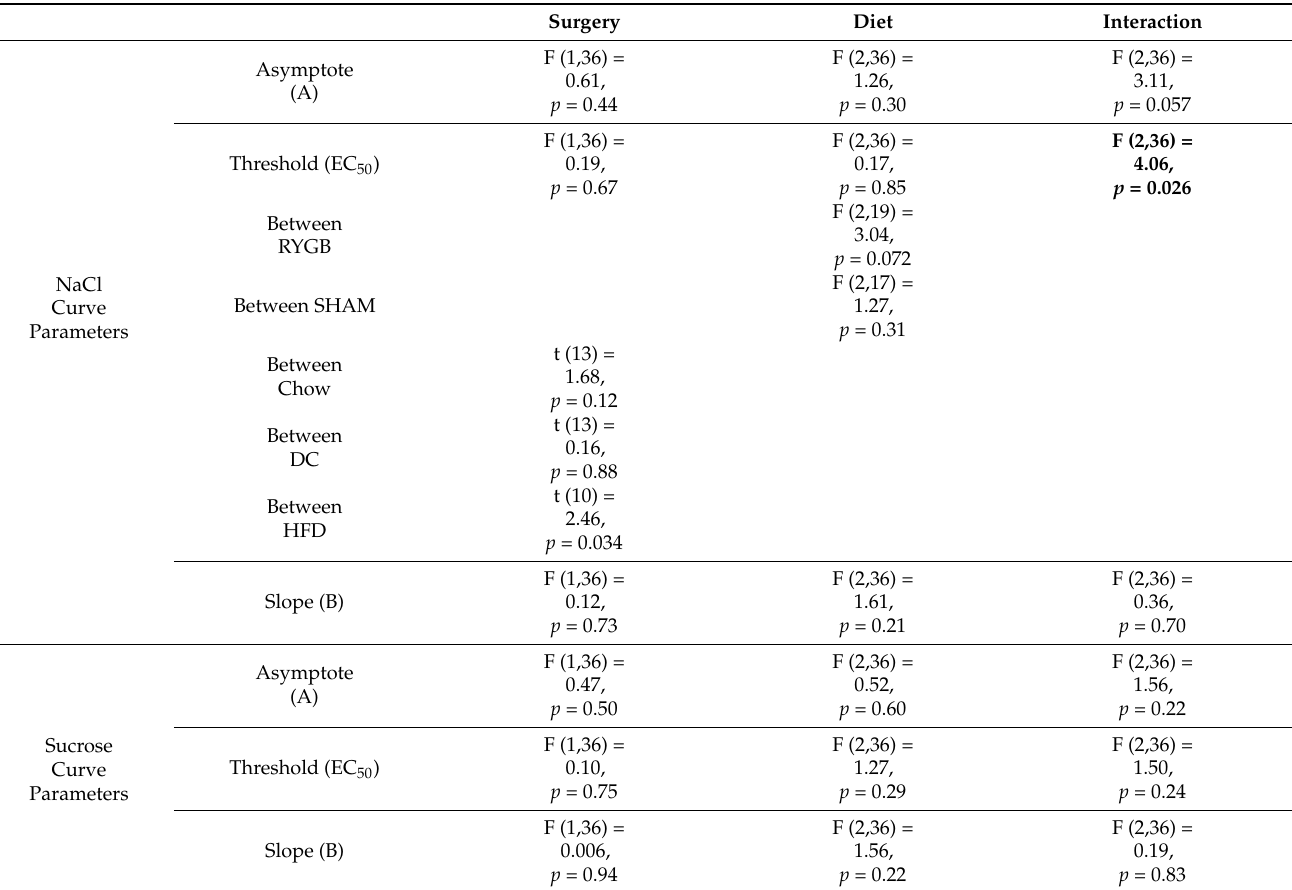
Table 7. Statistical analysis comparing each of the three parameters included in the logistics function that was used to generate individual curve fits for NaCl and sucrose testing. For paired comparisons, uncorrected p -values are depicted; those that survived Bonferroni corrections are bolded . Significant ANOVAs are also bolded .